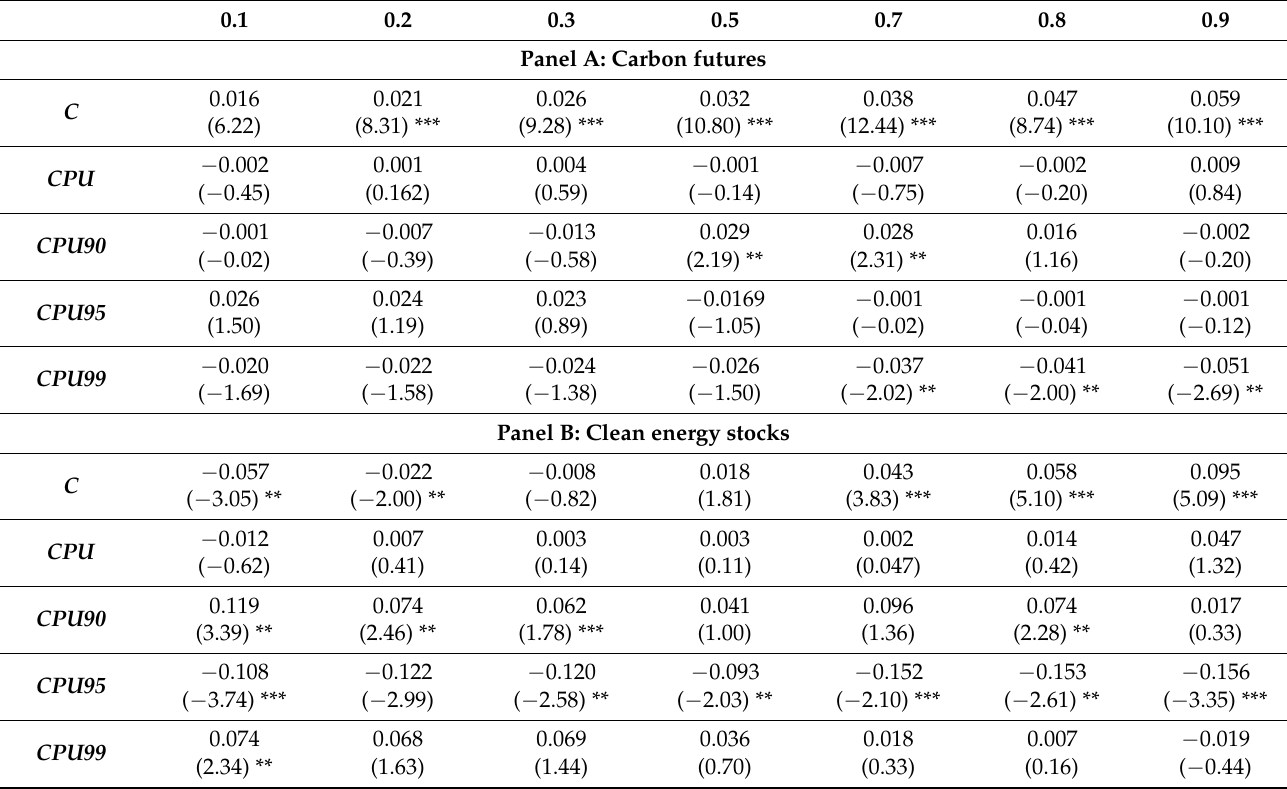
Table 5. Quantile regression with dummy for sub-sample: post-Paris Agreement of